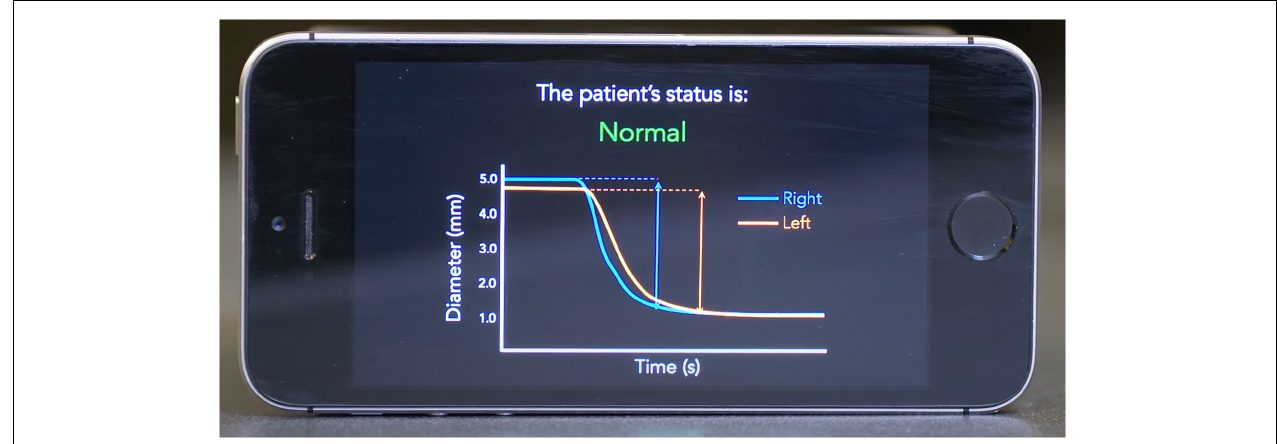
FIGURE 1 | Example mockup screen from the PupilScreen application. A pupillary light reflex (PLR) curve is shown with constriction demonstrating a normal healthy result based on the curve morphology.